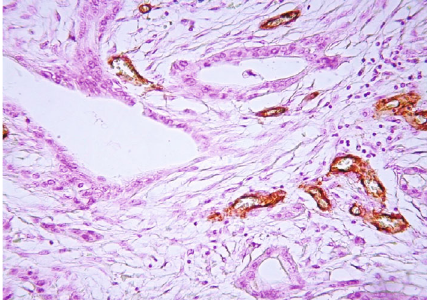
Figure 10: Pancreatic ductal carcinoma, hypovascular area, immunohistochemical staining, CD 34, ×